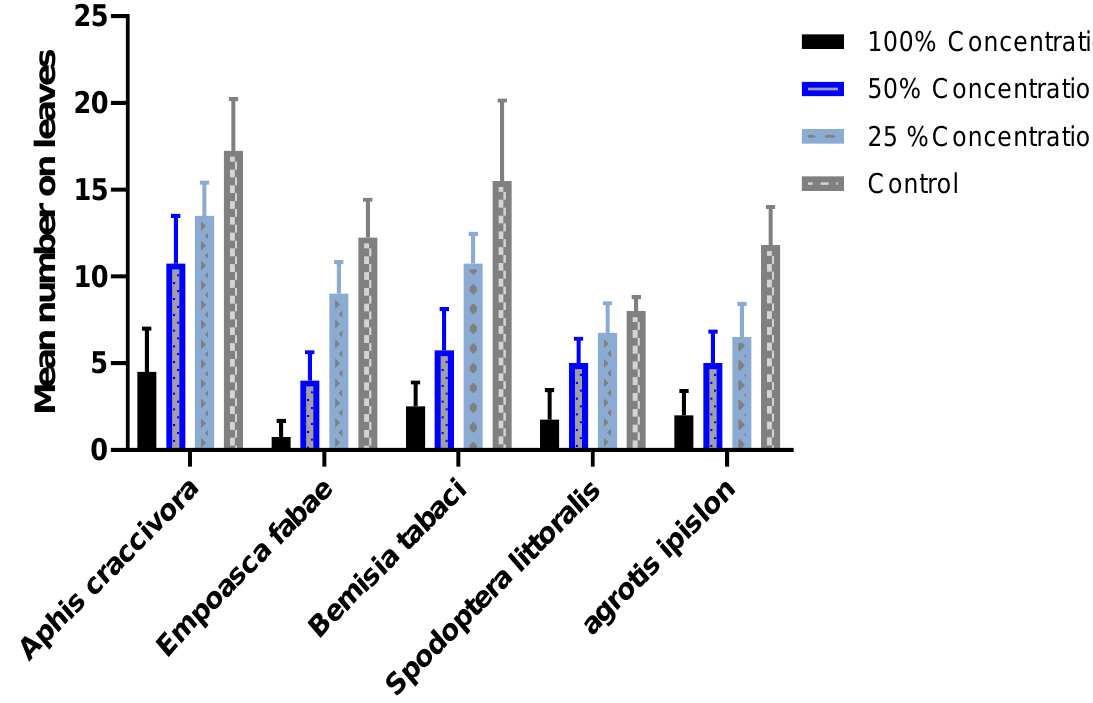
Figure 4. The mean numbers of insects collected from plots of each treatment. Data were recorded with the mean number of larvae caught in each plot according to the concentration; for Spodoptera, these numbers were 1.7, 5, 6.7, and 8.0 with 100, 50, and 25% of the SCG extract and the control, respectively. At an earlier plant age, the larvae of Agrotis ipsilon were collected from plants for each of the different treatments, and the mean numbers were 2, 5, 8.5, and 11.8 specimens/plant with the concentrations of 100, 50,